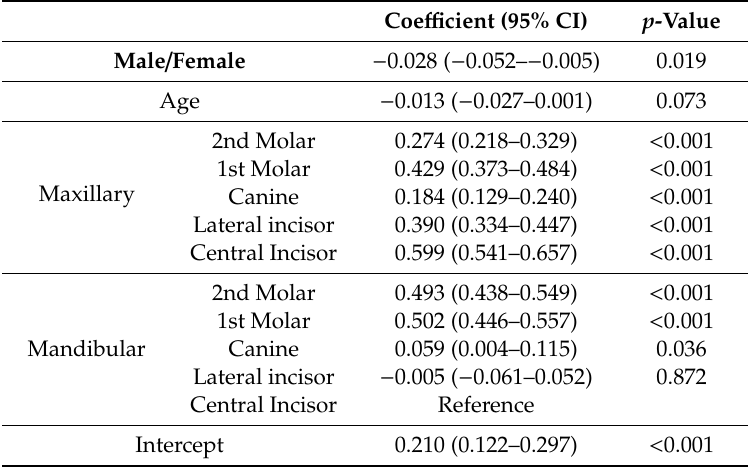
Table 1. Mixed-e ff ect model analysis of the prevalence of dental caries at tooth